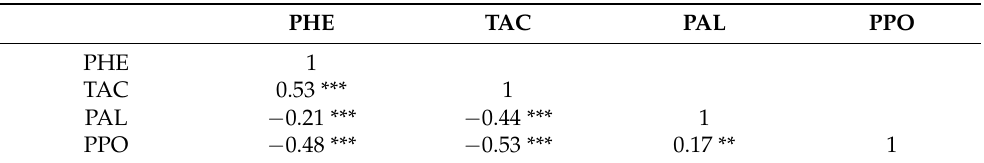
Table 5. Pearson correlation coefficients (r) and corresponding significance levels between the measured biochemical parameters in 2018/2019.